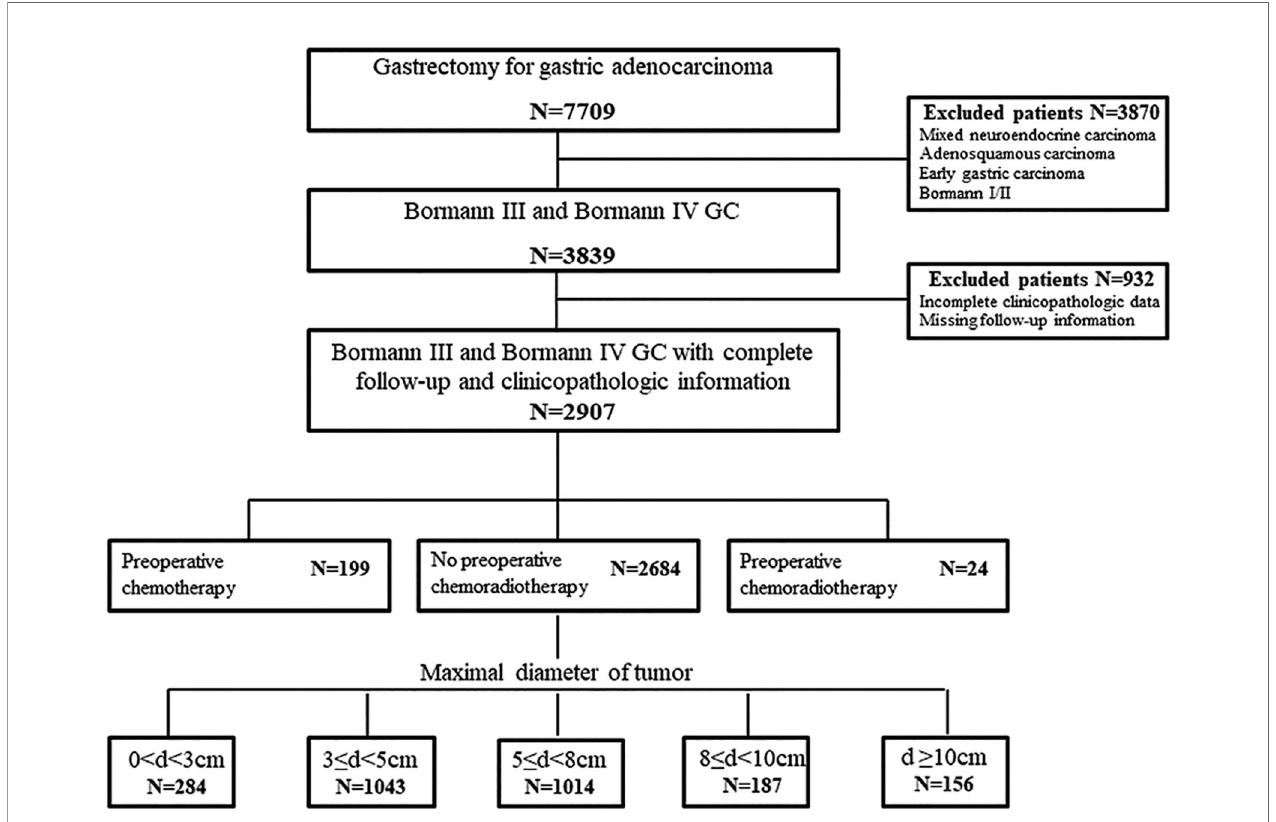
FIGURE 1 | The fl owchart of retrospective analysis for gastric linitis plastica